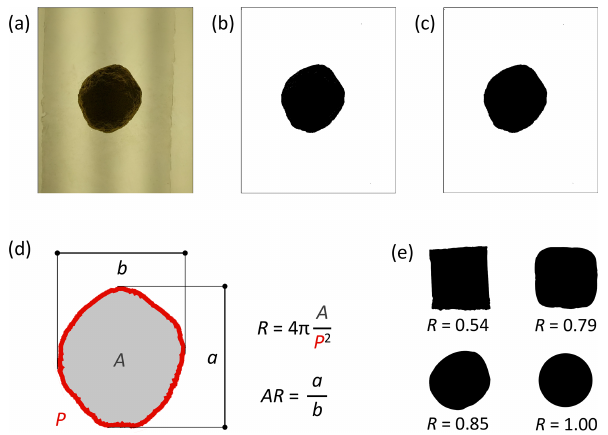
Figure 4. A visual depiction of the ImageJ macro used to determine shape parameters. First, a photograph was taken of the particle at a fixed distance over an LED light table. The macro (a) cropped the image to include only the particle, (b) converted the original im- age into a binary image, then (c) filled any holes within the particle shape. The macro then (d) measured the area ( A ), perimeter ( P ), major axis ( a ), and minor axis ( b ) of the particle. These measure- ments were used to calculate circularity ( R ) and aspect ratio (AR), parameters that were used to quantify shape change over the course of the rounding experiments. Circularity measures how closely a shape approaches that of a circle, where R = 1 indicates a perfect circle and R < 1 indicates deviations from a circle. Panel (e) shows circularity measurements for particles of different